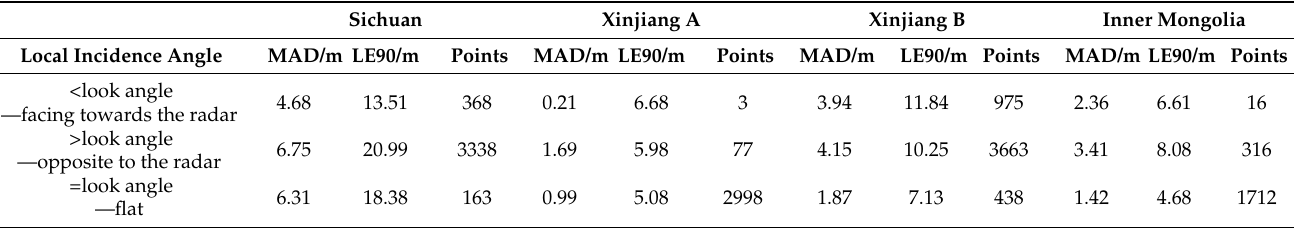
Table 3. Statistical summary of SRTM error in relation to local incidence angle. Sub-swath 1: approximately 30–40 ◦ look angle. Sub-swath 2: approximately 41–48 ◦ look angle. Sub-swath 3: approximately 47–53 ◦ look angle. Sub-swath 4: approximately 52–59 ◦ look angle.